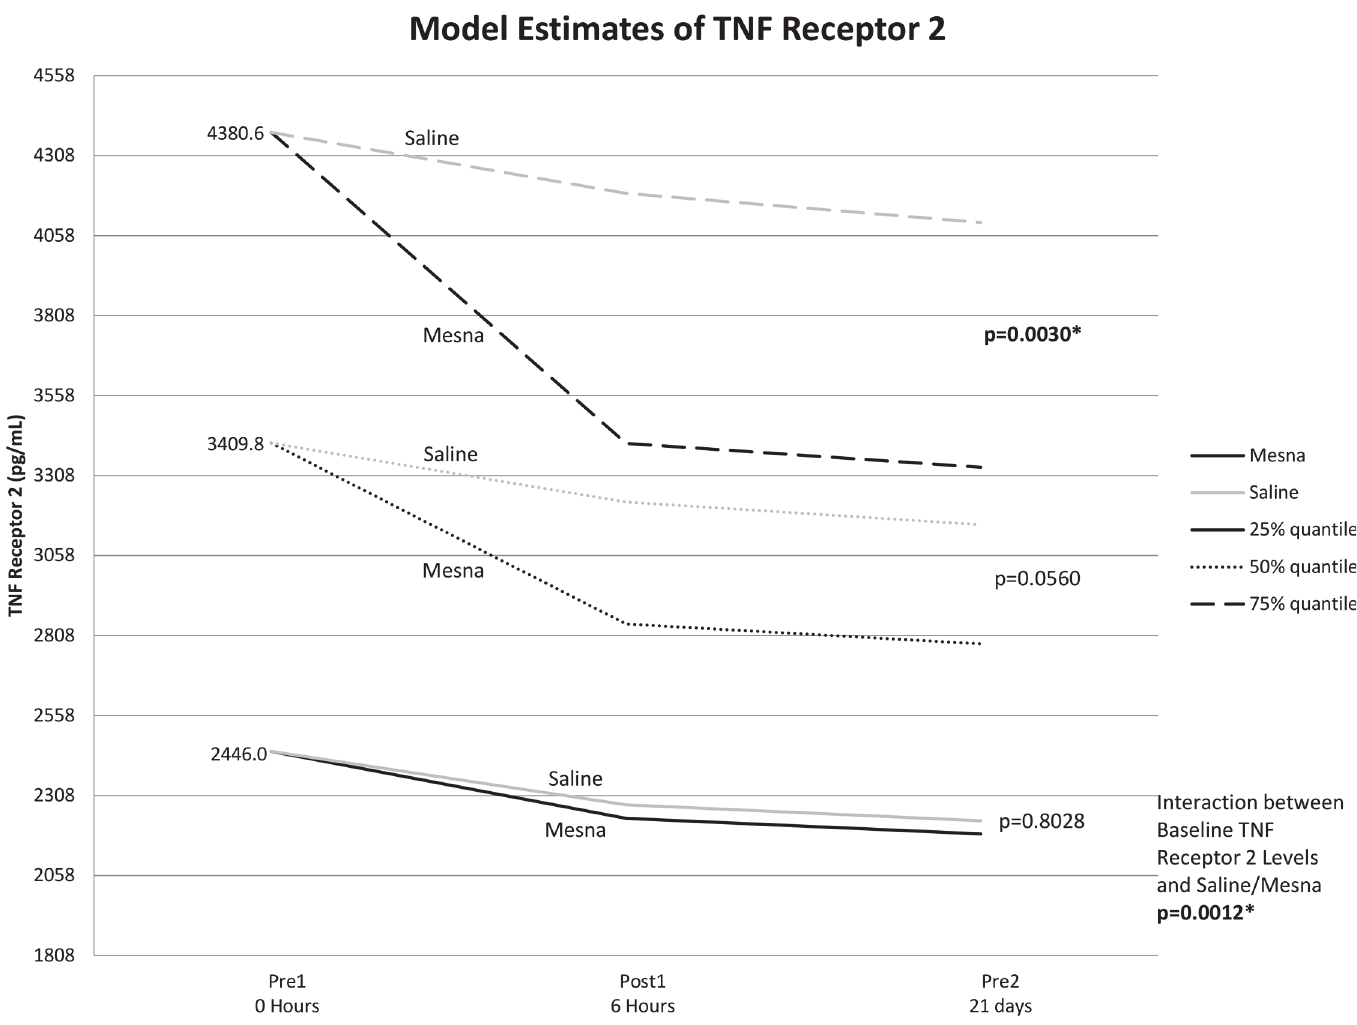
Fig 5. Mean estimates of TNF receptor 2 levels for each time point by mesna and saline groups calculated from linear mixed model adjusting for baseline level, time, group (mesna vs saline), chemotherapy regimen and baseline by group